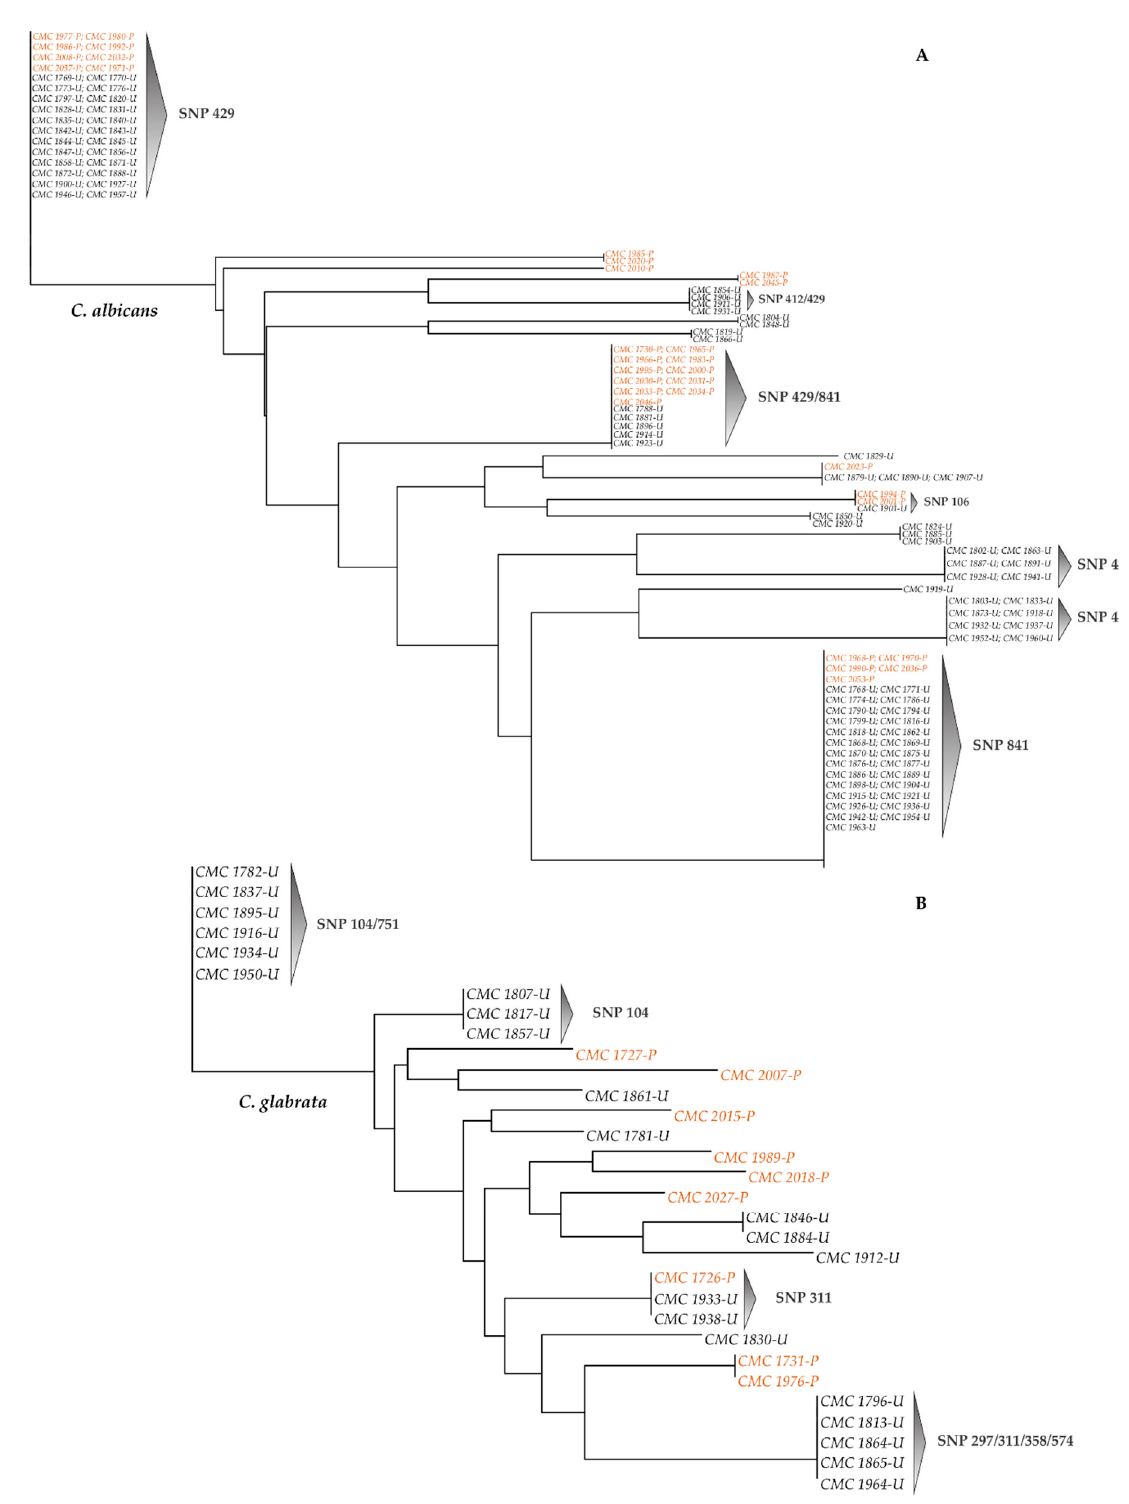
Figure 8. Neighbor-joining phylogenetic trees based on SNP profiles. ( A ) C. albicans neighbor-joining phylogenetic tree; ( B ) C. glabrata neighbor-joining phylogenetic tree. Black plain characters: Udine Hospital; orange plain characters: Pisa Hospital.